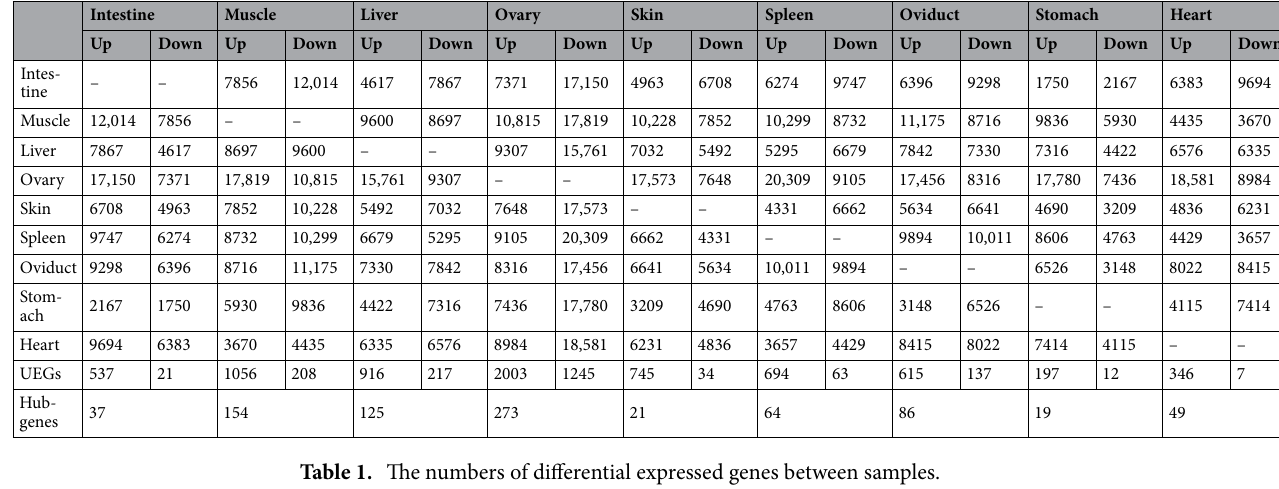
Table 1. The numbers of differential expressed genes between samples.